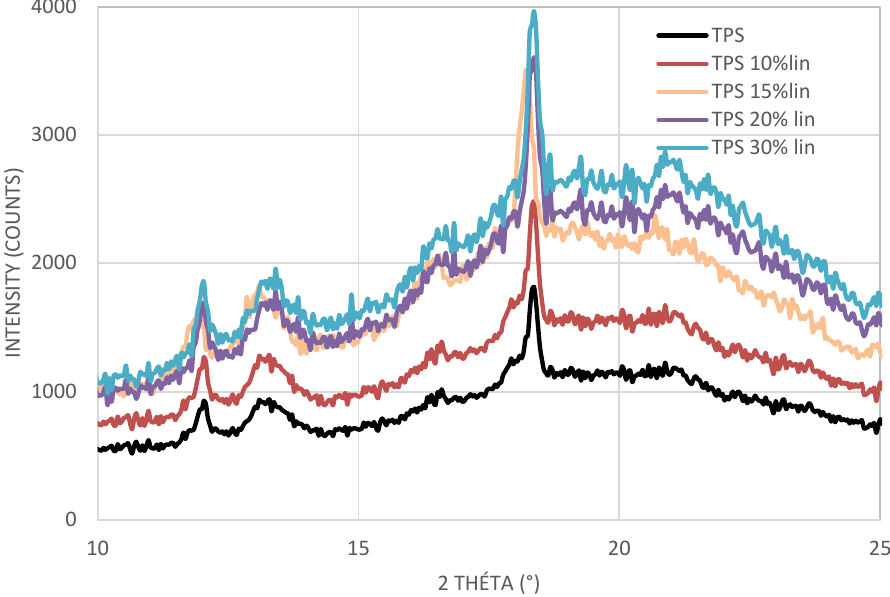
Figure 9. Normalized DRX spectrum of TPS/(% percentage) shives of flax mixtures.